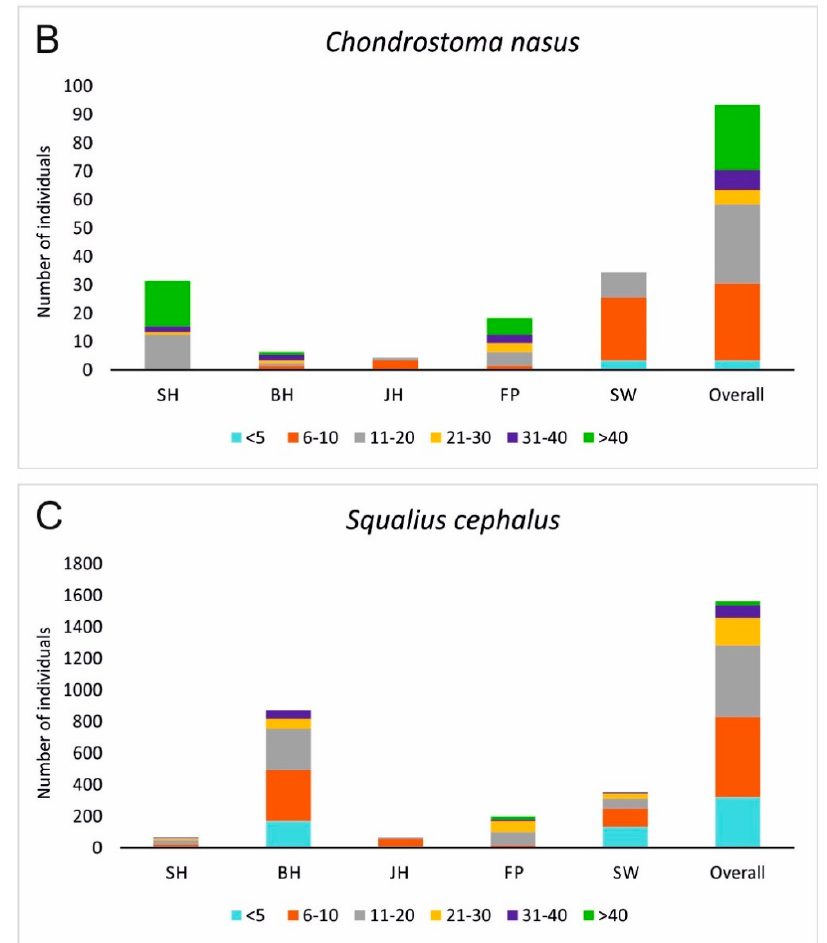
Figure 6. Fish population structures of Barbus barbus ( A ) and Chondrostoma nasus ( B ) displayed in different size classes for the five assessed habitat types. Additionally Squalius cephalus ( C ), a generalist species that is most common in the Günz and comprises a self-sustainable population is presented. SH = fast flowing instream habitat with gravel, BH = bank habitats, JH = structured shallow water zones, FP = nature like fish pass, SW = former river course below the spillway. <5 = size class of fish 5 cm